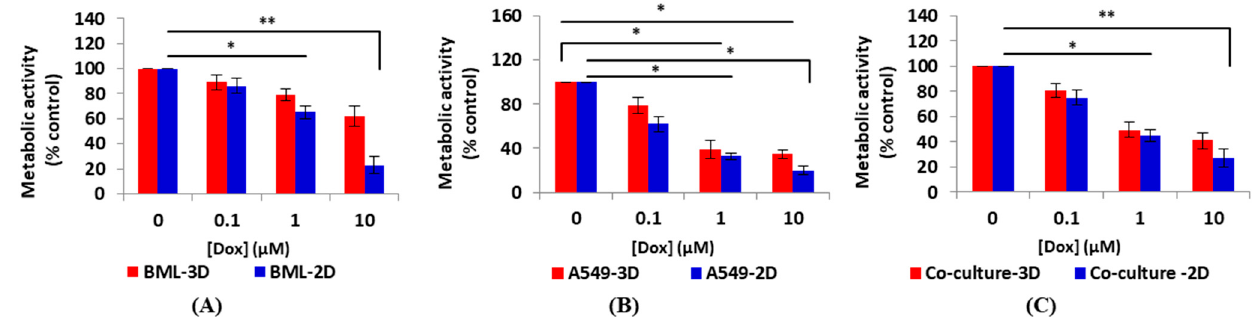
Figure 5. Comparison of metabolic activity reduction after drug exposure in 3D and 2D culture for each group. In all groups, cells were more resistant to drugs in 3D MCTSs. ( A ) Patient-derived cell metabolic activity in 3D MCTSs and 2D model. Spheroids are drug resistant as drug penetration is more difficult in 3D form. Therefore, the metabolic activity of spheroids decreased non-significantly compared to the control group when they were exposed to various concentrations of drugs. However, a decrease in metabolic activity was observed by increasing the drug concentration, but this decrease was not statistically significant. Cells in 2D demonstrated statistically significant decreases compared to the control group when exposed to 1 µM (* p < 0.05) and 10 µM (** p < 0.001) of Dox. ( B ) Established lung cancer cells A549 showed a significant decrease in metabolic activity when exposed to 1 µM of Dox and higher under both 3D and 2D conditions (* p < 0.05). ( C ) Co-culture of lung cancer cells A549 and primary human osteoblasts at a ratio of 1:1 to mimic the tumor–stromal reaction. Metabolic activity of spheroids decreased non-significantly when compared to the control group by increasing the Dox concentration. In the 2D model, metabolic activity decreased statistically significantly compared to the control when the cells were exposed to 1µM (* p < 0.05) and 10 µM (** p < 0.001) of Dox. p < 0.05 was considered statistically significant. All assays were performed as triplicates per trial in three independent experiments. (Error bars represent ± SE, n = 3).